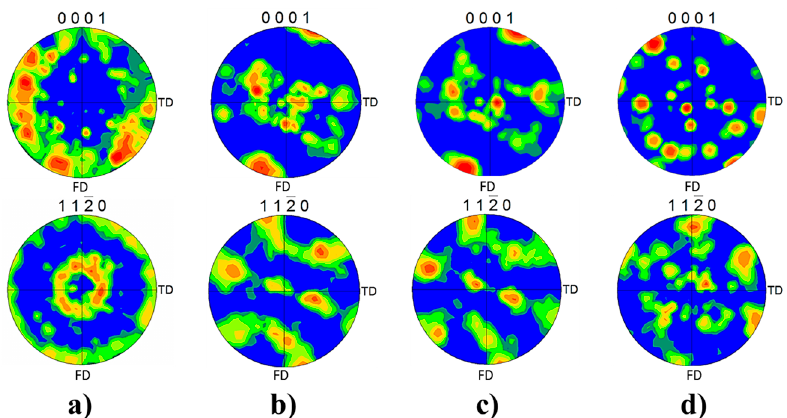
Figure 17. Pole figures from the α -Ti phase for the ( a ) base material; ( b ) Regions 2; ( c ) 3 and ( d ) 4 in the deformed rivet tip (Figure 11b). FD is the forging direction which is analogous to the axial force direction applied during FricRiveting, and TD is the transversal direction.